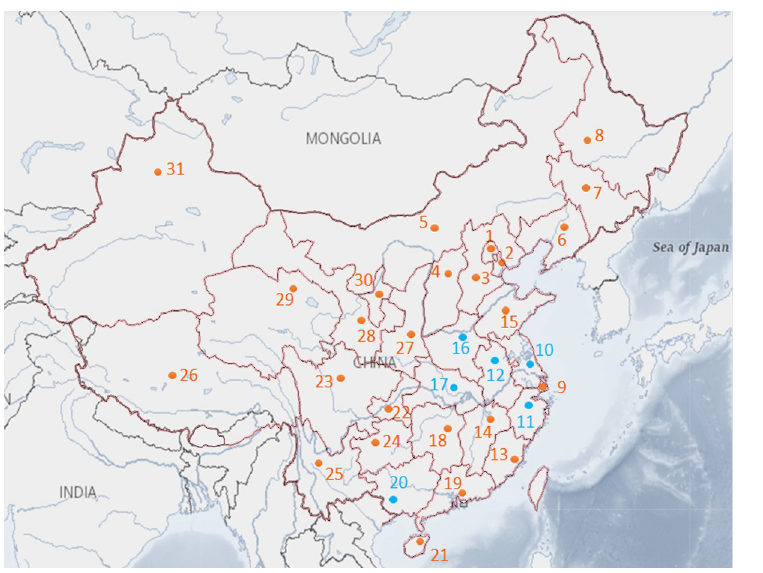
Fig 2. Map of provinces and municipalities in mainland China.